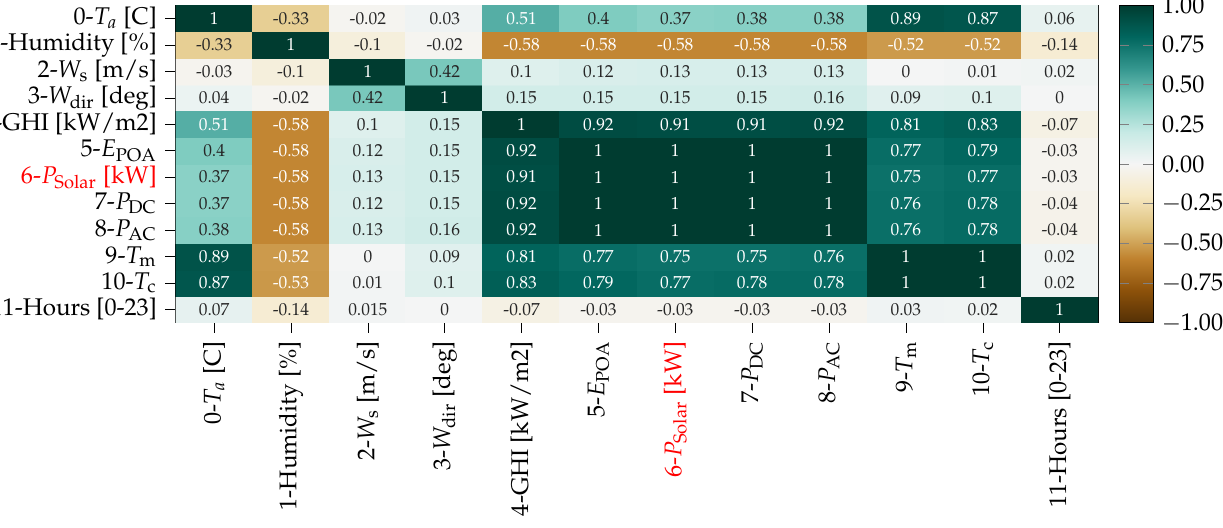
Figure 8. Heatmap representing Pearson